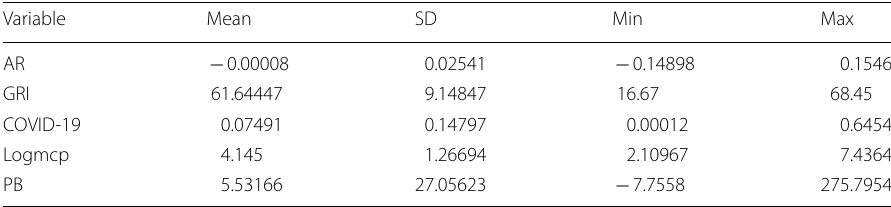
Table 1 Summary